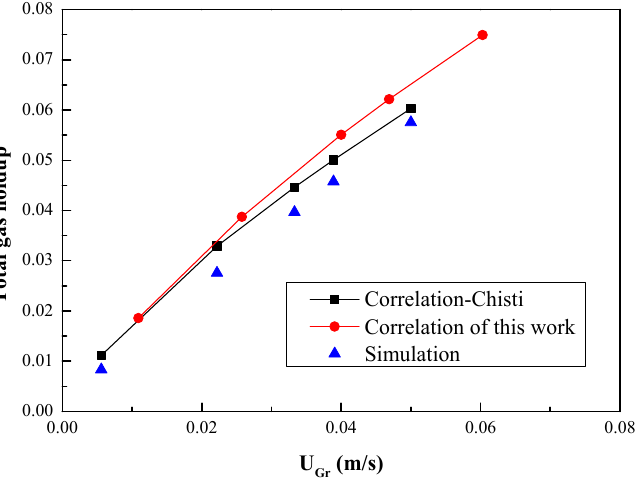
Figure 8. Comparison of total gas holdup calculated by the correlations and CFD simulation at different gas superficial velocities U Gr .